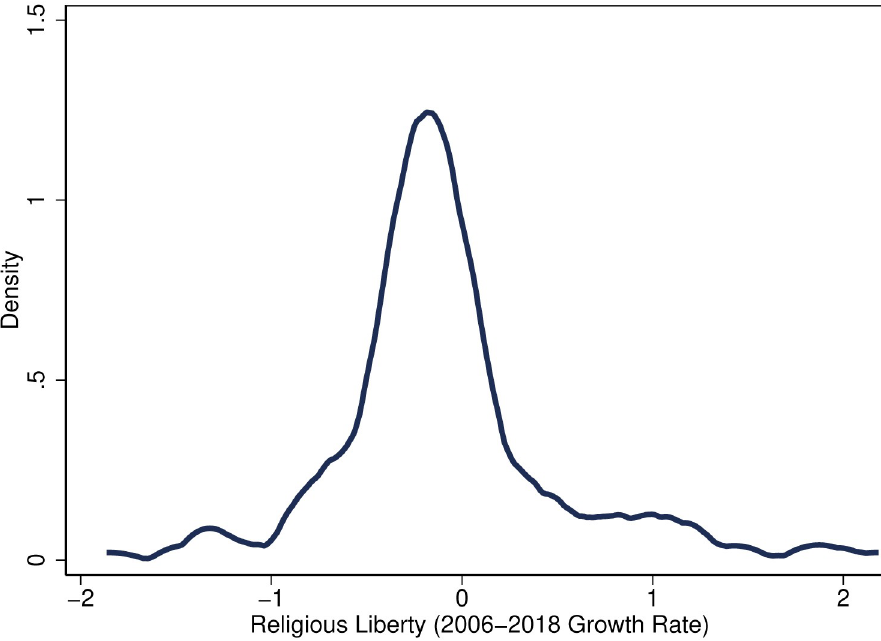
Fig 4. Distribution in growth in religious liberty, 2006-2018. Sources: Varieties of Democracy. The figure plots the distribution of growth rates in the religious liberty index between 2006 and 2018 across countries. The sample is trimmed so that there is no observation with a growth rate above 300% or below